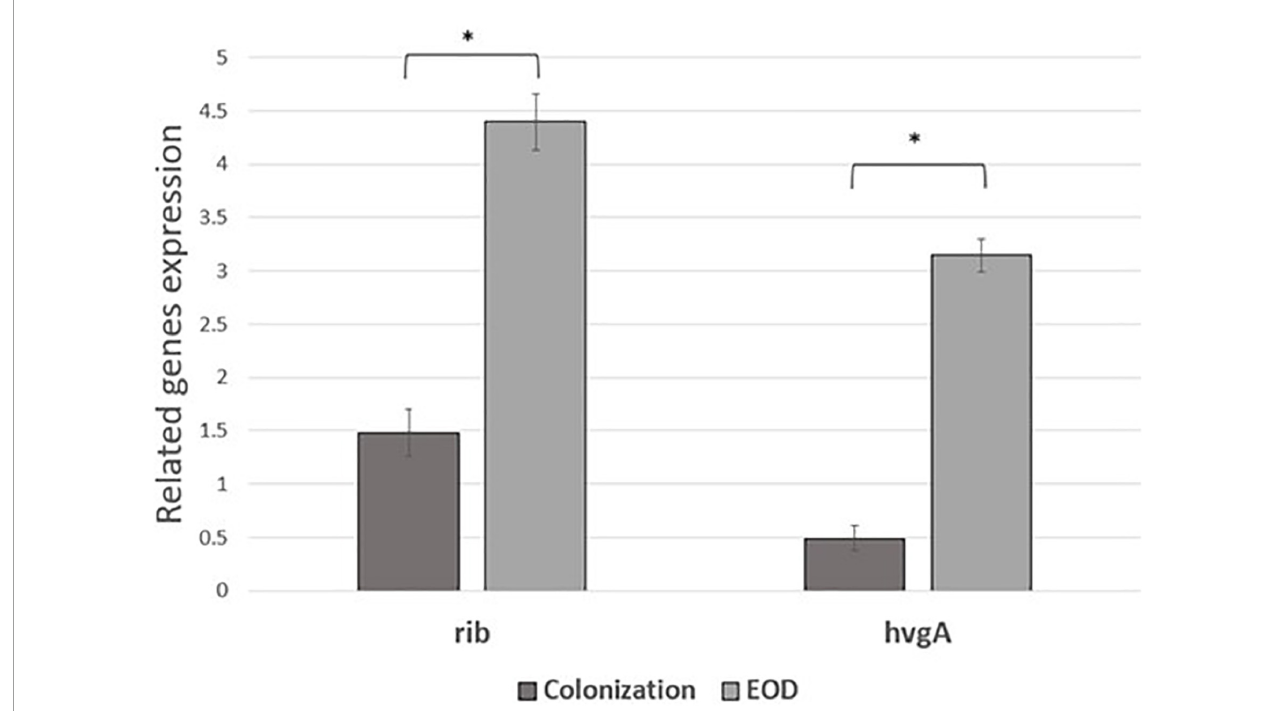
FIGURE4 The expression of rib and hvgA gene expression in early-onset disease (EOD) and colonizing isolates from Mayanei Hayeshua Medical Center (MHMC) were analyzed by qRT-PCR. Amounts of each transcript were normalized to rpoB gene and expressed relative to this gene in reference strain ATCC BAA611. The expression level of ATCC BAA611 strain was defined as 1. Columns represent the relative mRNA expression level of each gene from each strain. Values are represented as means ± SD ( n = 8) from three independent qRT-PCR experiments. Error bars show SD. Asterisk indicates a significant difference ( ∗ p < 0.05 by t -test).